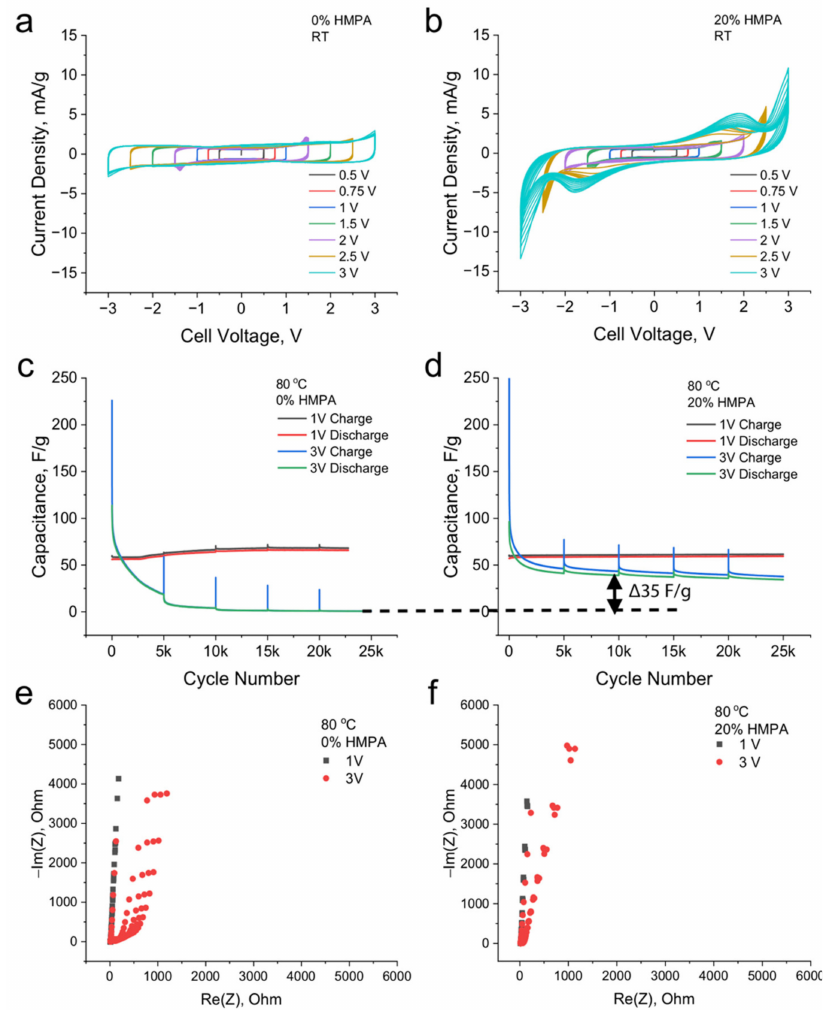
Figure 1. The cyclic voltammetry of 1m NaPF 6 without HMPA ( a ) and with HMPA ( b ). The galvano- static cycling measurements of 1m NaPF 6 in DME without HMPA ( c ) and with HMPA ( d ) at 5 mA at 80 ◦ C. The spike in capacitance is an artifact from performing EIS at OCV before every 5000 cycles and normalizes after 500 cycles. The Nyquist plots of cells were taken every 5000 cycles without HMPA ( e ) and with HMPA ( f ). An increase of around 40 F/g of stable cycling can be observed with the addition of HMPA at 80 ◦ C and cycling at 3